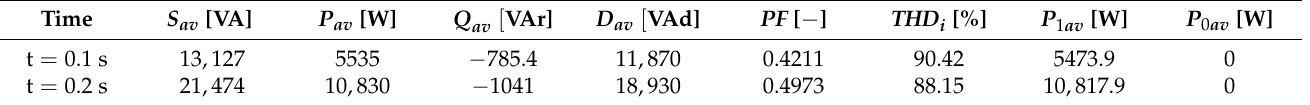
Table 18. Simulation results before and after the change (at steady states).